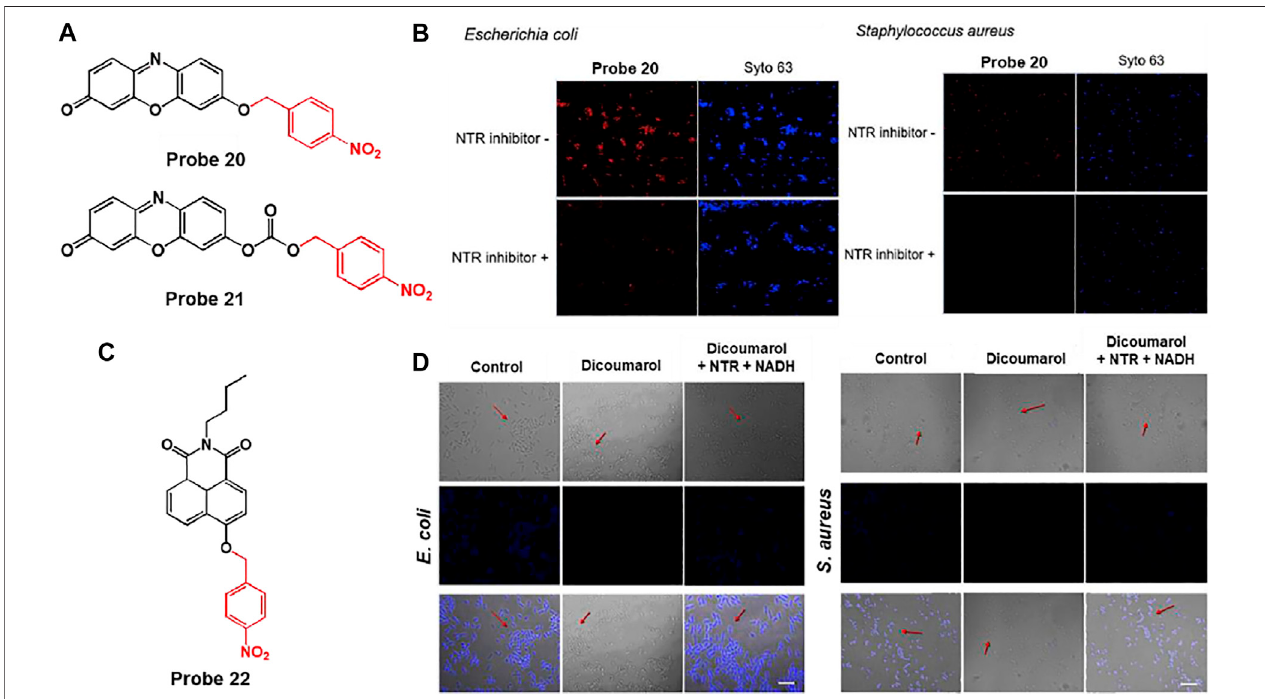
FIGURE10|(A) Chemicalstructuresofprobes20and21. (B) Confocalmicroscopyimagesofbacteriatreatedwithprobe20withoutorwithanNTRinhibitor.Syto 63 was used to stain live cells. Reproduced with permission from Yoon et al. (2019). Copyright © 2019, Elsevier. (C) Chemical structure of probe 22. (D) Confocal microscopy images of bacteria treated with probe 22 without or with dicoumarol (NTR inhibitor). Reproduced with permission from Zhang et al. (2020a). Copyright © 2019, Elsevier.